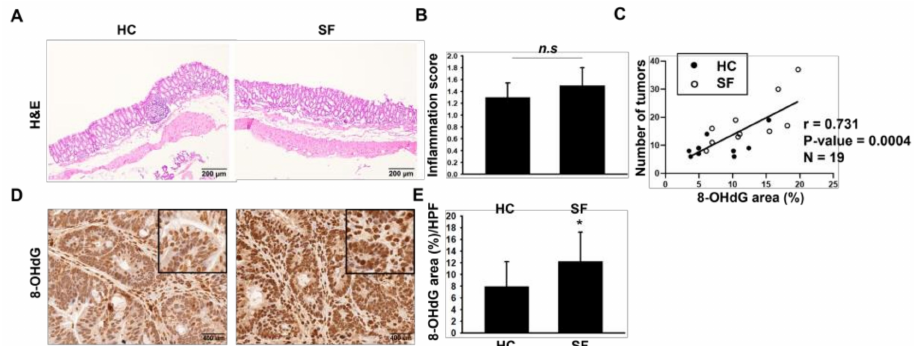
Figure 2. Results of H & E staining and immunohistochemical staining for 8-OHdG. ( A ) Represen- tative H & E-stained images of colon tissue and ( B ) comparison of inflammation scores. ( C ) Spear- man’s correlation analysis between number of tumors and 8-OHdG area (%). ( D ) Representative immunohistochemical-stained images for 8-hydroxyl-2 (cid:48) -deoxyguanosine (8-OHdG) in the colons of mice from the HC and SF groups and ( E ) quantification of the stained area (%). Data are presented as the mean ± S.E.M. * p < 0.05 compared with the HC group, as determined by the Mann-Whitney U test. n.s.